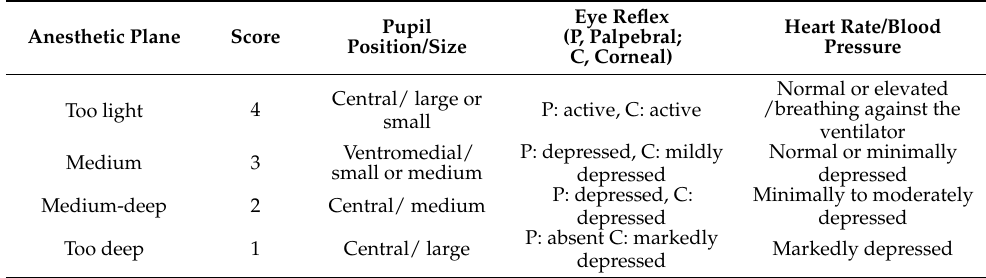
Table A1. Subjective score categories and criteria used for evaluation of the depth of anesthesia score in the isoflurane-anesthetized horse. Modification from